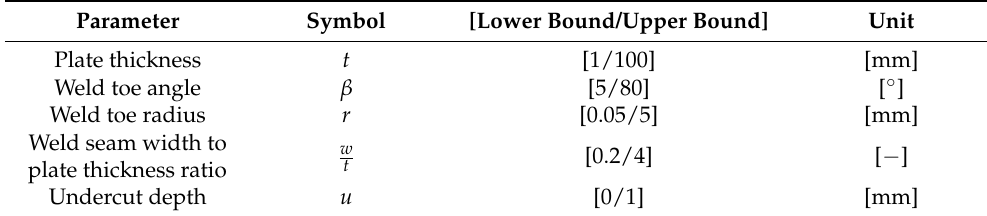
Table 1. Parameter ranges of the Finite Element Models.